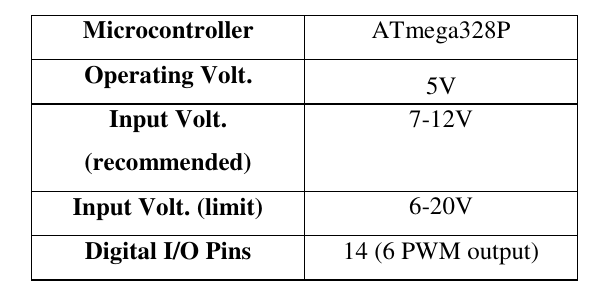
Figure 3. Pinout of ATmega328P